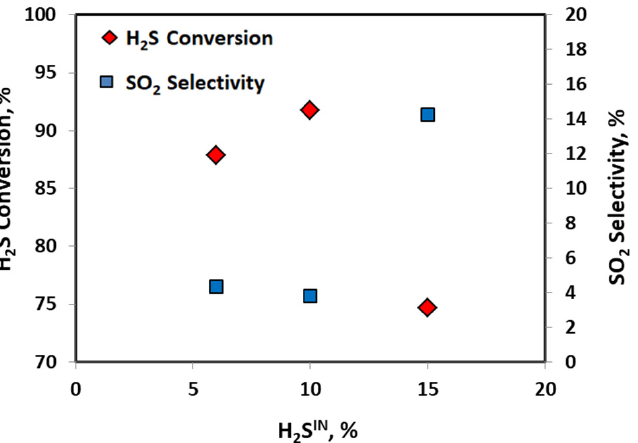
Figure 4. Influence of the H 2 S inlet concentration over 20 V-CeO 2 catalyst on the H 2 S conversion and SO 2 selectivity (O 2 /H 2 S = 0.5, T = 327 °C, contact time = 0.6 s). The highest value of H 2 S conversion and the lowest SO 2 selectivity were observed when the H 2 S inlet concentration was 10 vol%. In the presence of a feed stream more